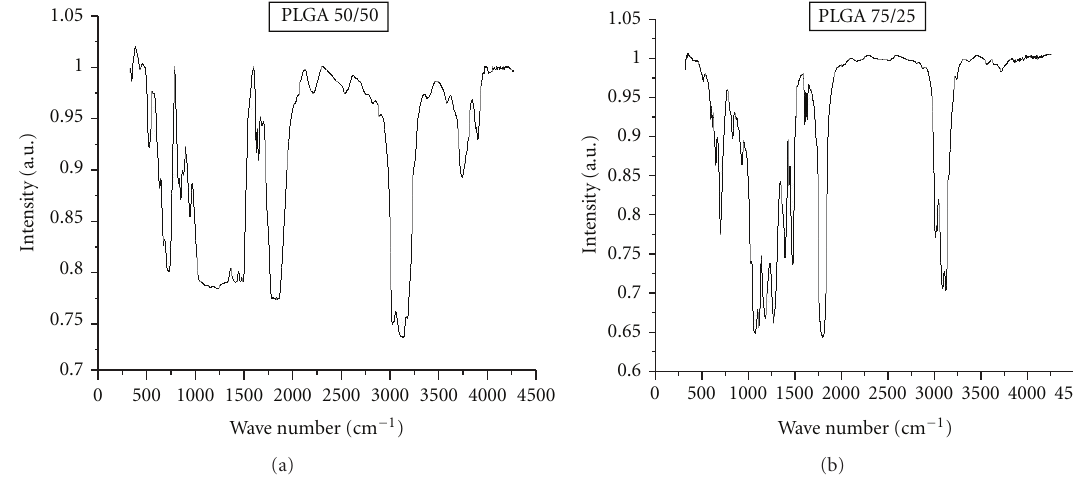
Figure 1: Infrarred spectra of PLGA 50/50 and PLGA 75/25 crystals, when dissolved in